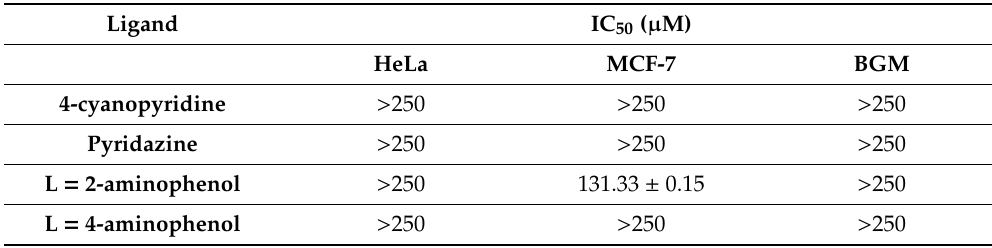
Table 5. Cytotoxicity expressed as IC 50 mean values ( µ M) of the ligands exposed to HeLa, MCF-7 and BGM cells for 48